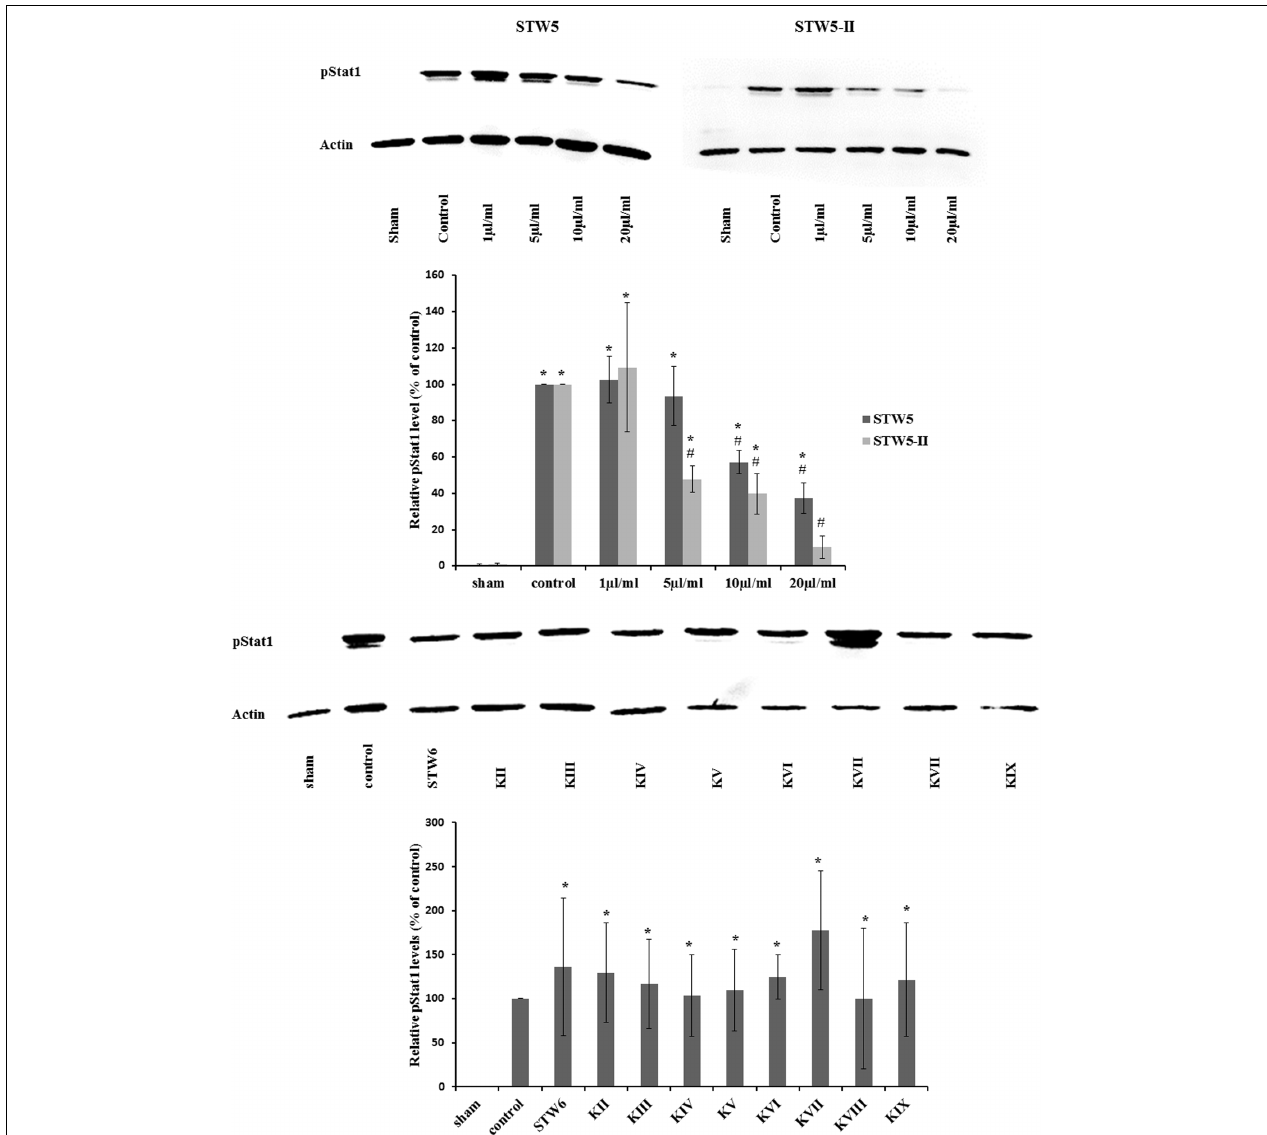
FIGURE 8 | Effect of STW5, STW5-II, and single plant extracts on Stat1 phosphorylation: NCM460 cells were treated with STW5 or STW5-II at indicated concentrations or single plant extract (percentage of STW5-II calculated for 10 µ l/ml according to content in the herbal preparation) for 4 h prior to induction with the CM (10 ng/ml TNF- α , 5 ng/ml IL-1 β , and 10 ng/ml IFN- γ ) for 30 min. Cell extracts were analyzed for phosphorylated Stat1 protein by western blotting. The lower panel displays the ratio of pStat1 to actin in relation to the control sample ( n = three independent experiments; # denotes statistical significance at p < 0.05 vs. control, ∗ denotes statistical significance at p < 0.05 vs.